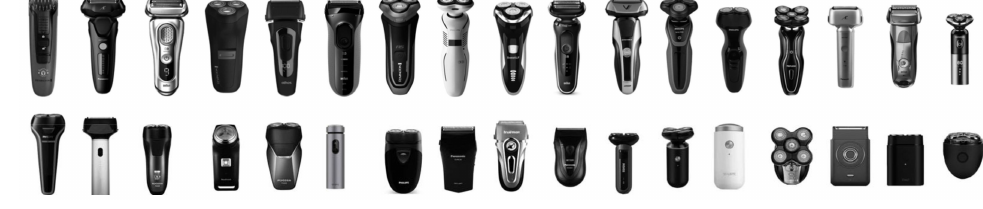
Figure 4. The 34 representative